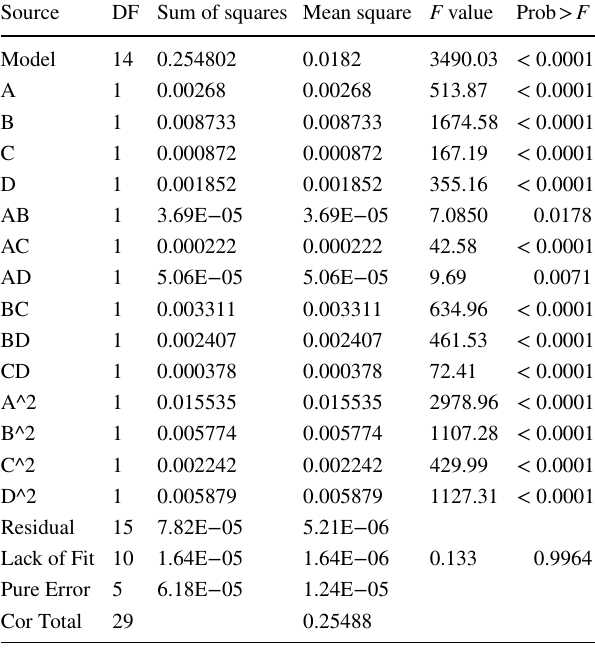
Table 7 ANOVA table for removal efficiency (natural log trans- formed removal